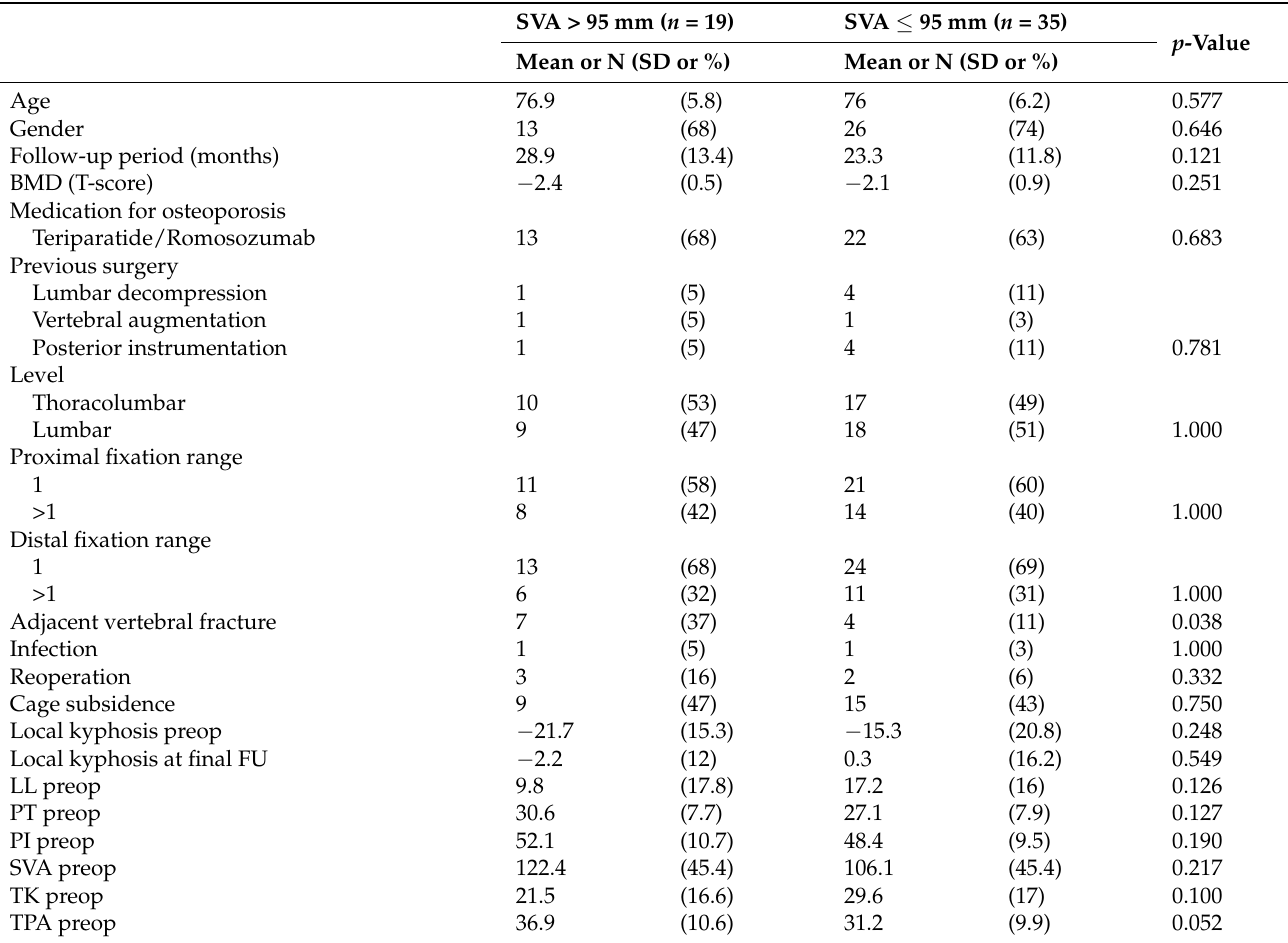
Table 2. Comparison between SVA > 95 mm and ≤ 95 mm groups by univariate analysis.